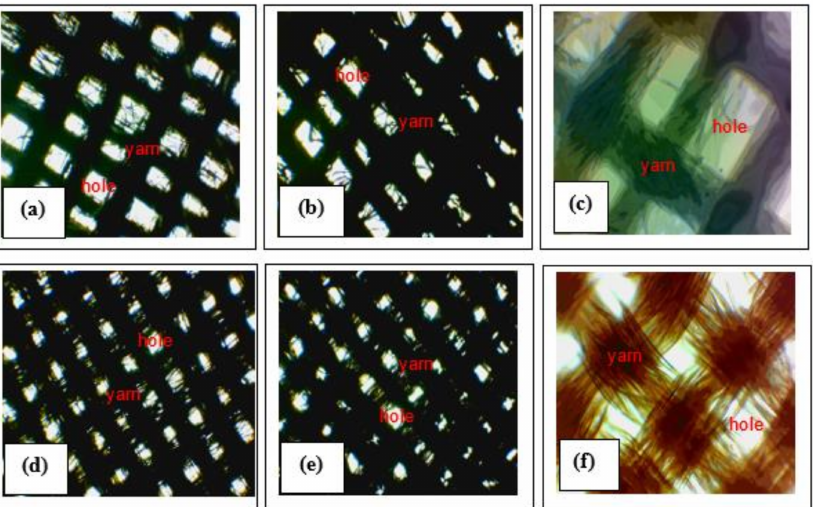
Figure 4. The digital camera microscope images of the cotton fabrics coated with ( a ) AgNPs- immobilized ACNPs of 5% w / v concentration, ( b ) ACNPs of 5% w / v concentration_cotton, ( c ). Origi- nal cotton fabrics; and that of the polyester fabrics coated with ( d ) AgNPs-immobilized ACNPs of 5% w / v concentration, ( e ) ACNPs of 5% w / v concentration_polyester, ( f ) Original polyester fabrics. Here, 40 × magnification digital camera was performed to ( a , b , d , e ); and 100 × magnification digital camera was performed to ( c , f